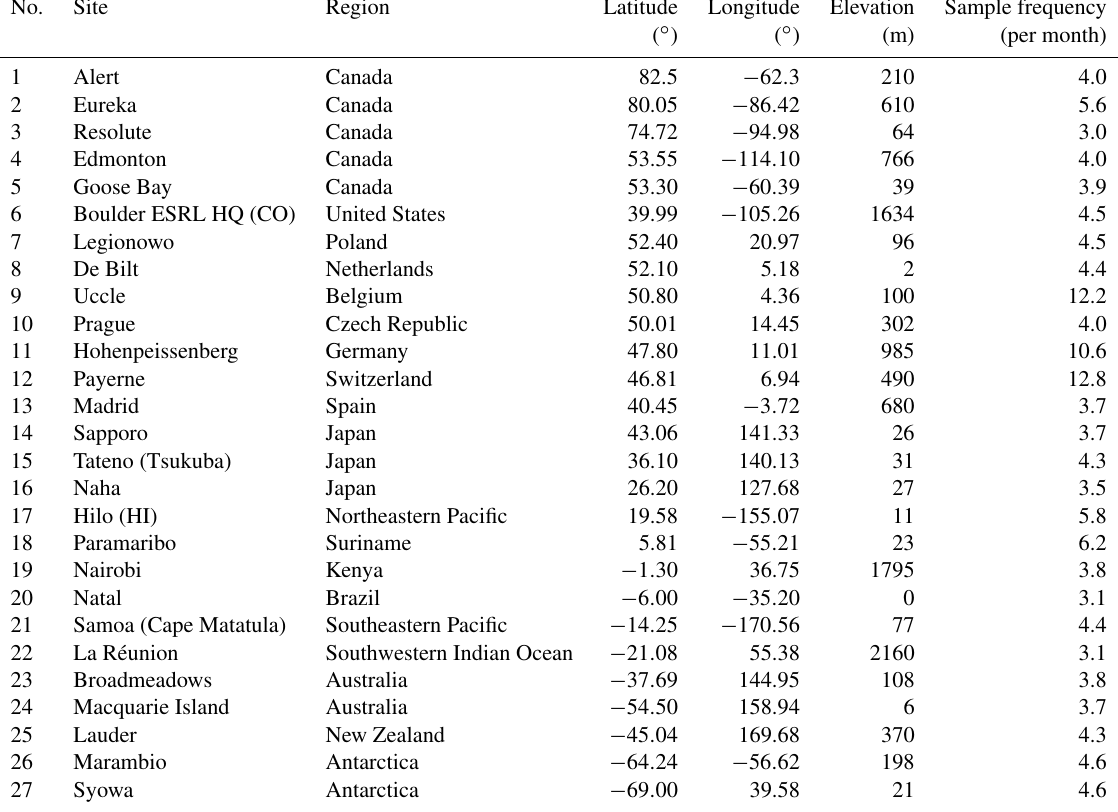
Table 1. List of the monitoring ozonesonde stations.